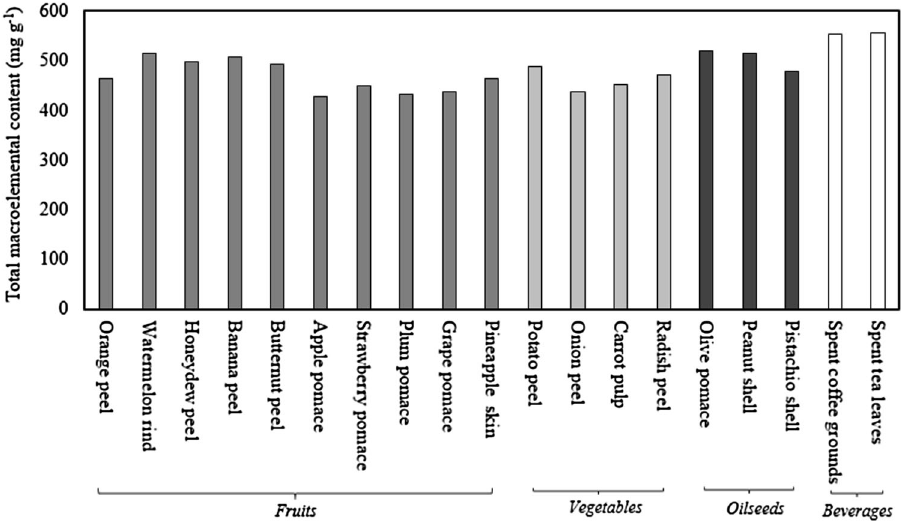
Fig. 1 Concentration of total